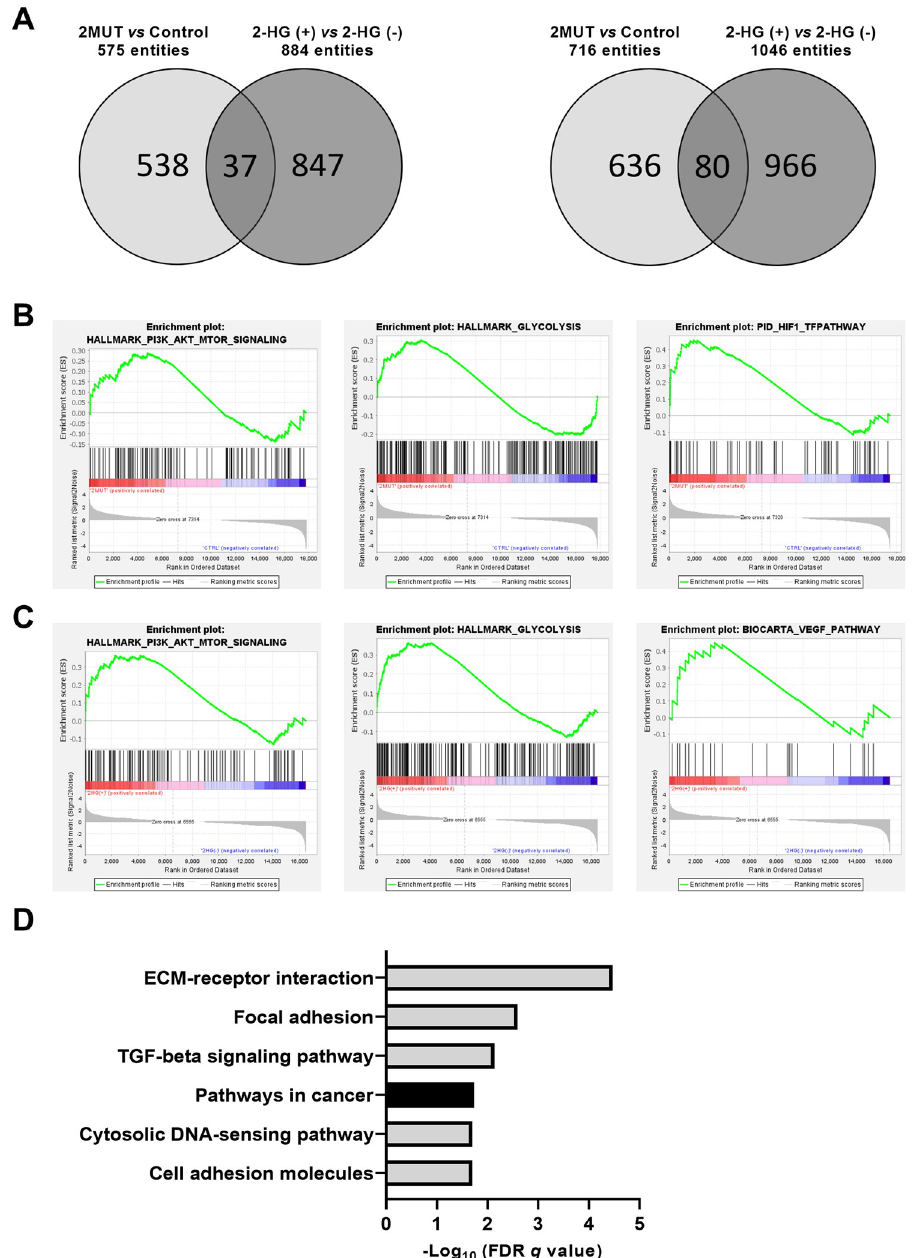
Fig 2. Genes with altered expression by the IDH2 mutant or 2-HG treatment. (A) Venn diagram of up-regulated (left) and down-regulated (right) genes by the overexpression of the IDH2 mutant or the treatment with 2-HG in MEF cells. (B) GSEA plot of enriched PI3K_AKT_MTOR signaling, glycolysis, and HIF1_TF pathway gene sets by the expression of the IDH2 mutant in MEF cells. (C) GSEA plots of enriched PI3K_AKT_MTOR signaling, glycolysis and VEGF pathway gene sets by the treatment with 2-HG in MEF cells. (D) FDRs of enriched gene sets by the IDH2 mutant and 2-HG treatment in KEGG pathway analysis.